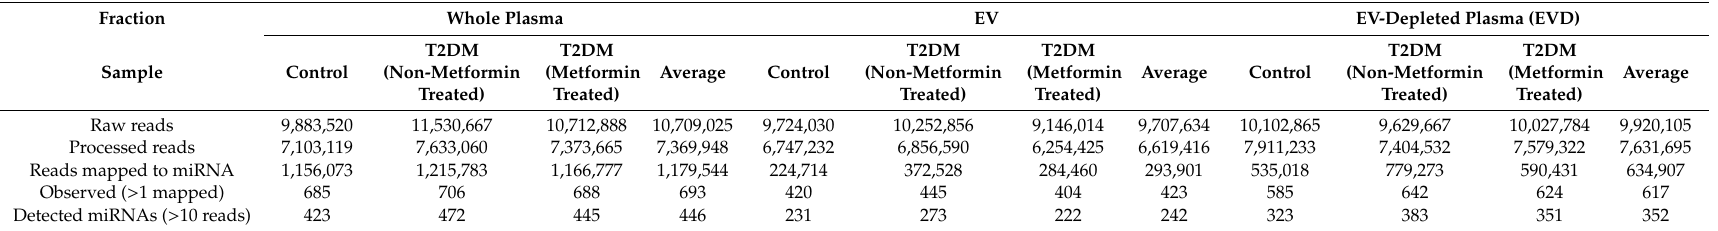
Table 1. Overview of sequencing